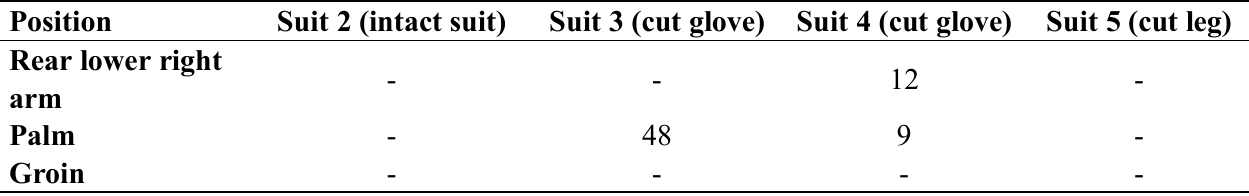
Table 2. Summary of cfu/swab per body position. Only those body positions that proved colonies.